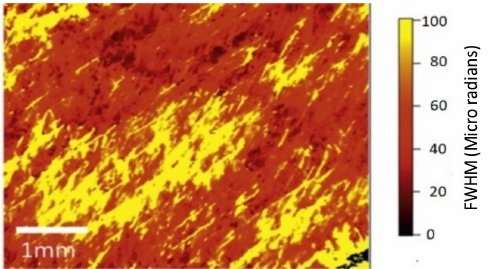
Figure 10. Rocking curve image of a 13 C doped single crystal diamond plate with R = 0.24. The image shows a general increase of dislocation bundles upon doping and an increase in average FWHM across the sample. The rocking curve map was generated along the (220) plane, and plate dimensions were approximately 5 mm × 5 mm. The image is from ref. [19]: Yap, C.M.; Tarun, A.; Xiao, S.; Misra, D S. MPCVD growth of 13 C-enriched diamond single crystals with nitrogen addition, Diam.